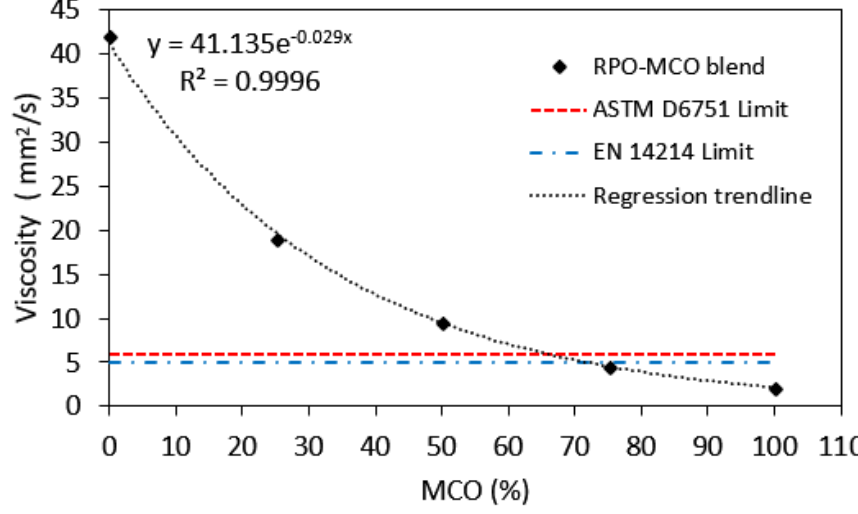
Figure 7. Correlation between MCO fraction and viscosity.